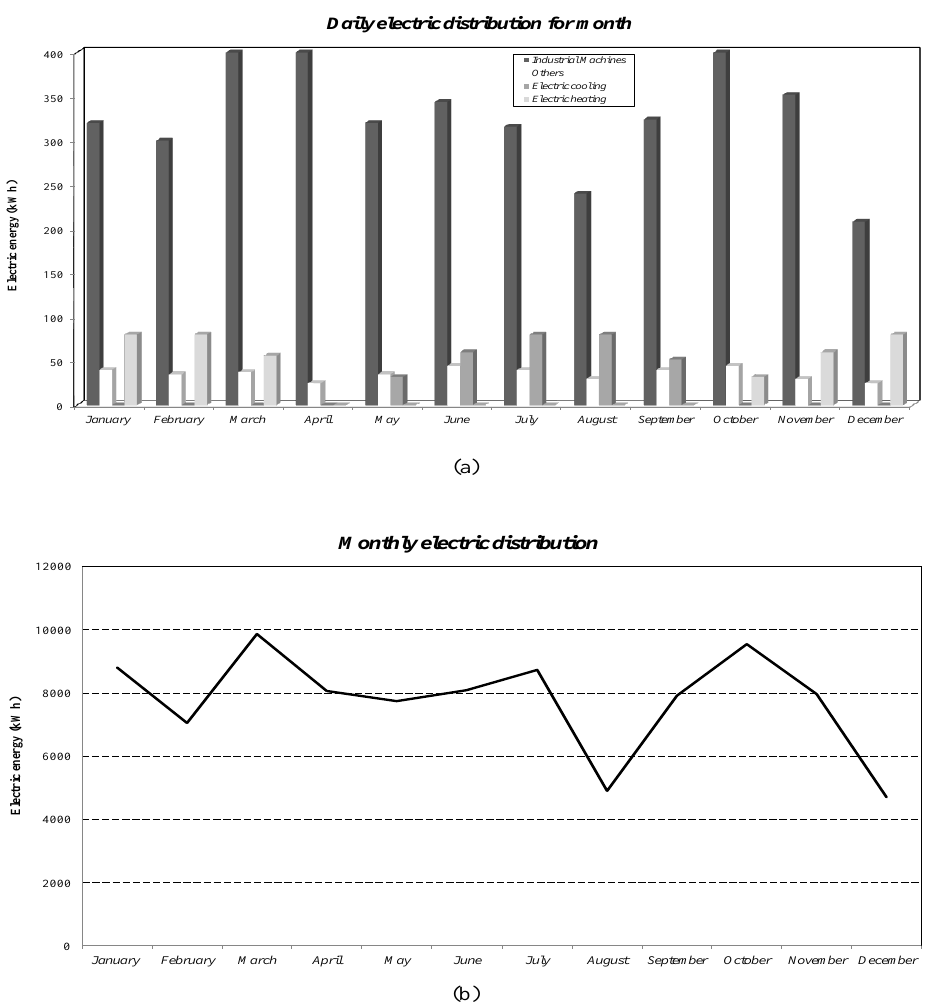
Figure 5. Electrical energy loads of the industrial user: Daily loads for each equipment ( a ), monthly cumulative loads ( b ).